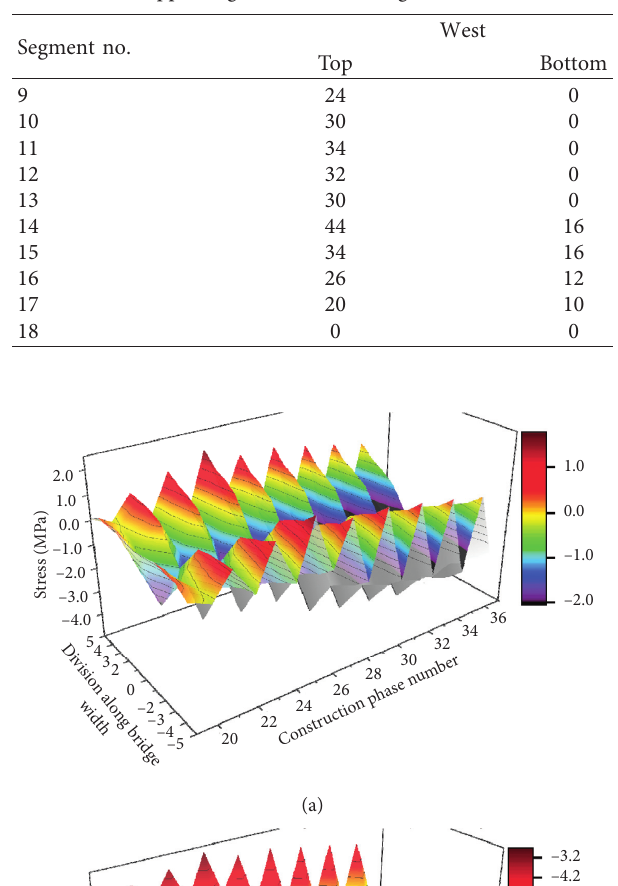
Table 5: Temporary prestressing scheme for improving safety reserve of the upper edge of the no. 10 segment.